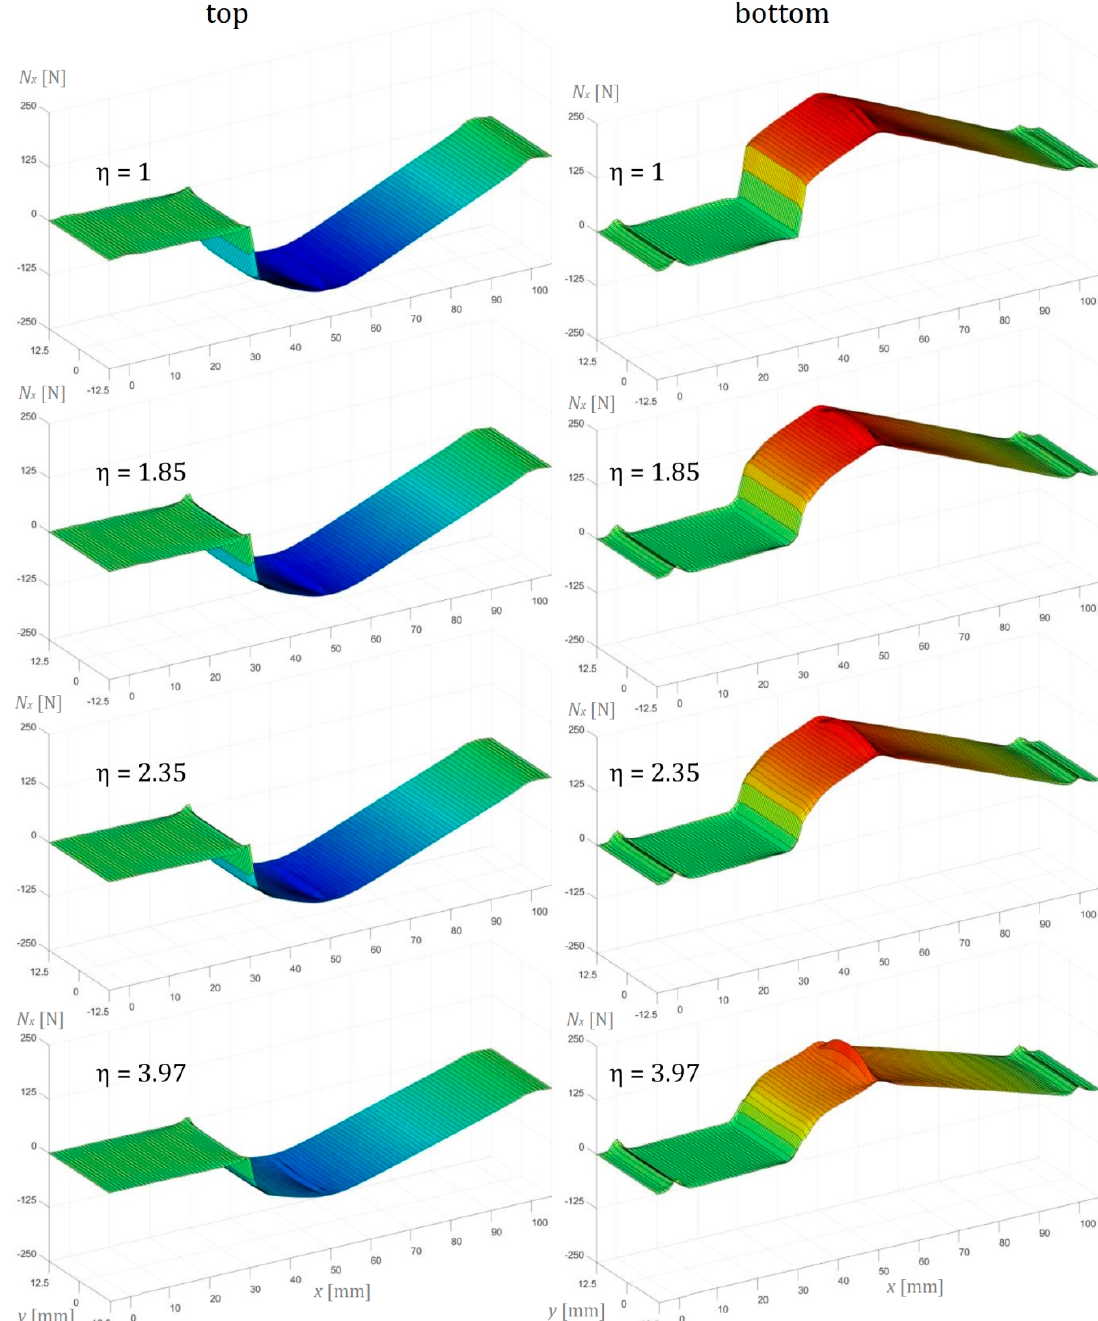
Figure 13. Normal forces per unit width in the longitudinal direction N x of the AENF.